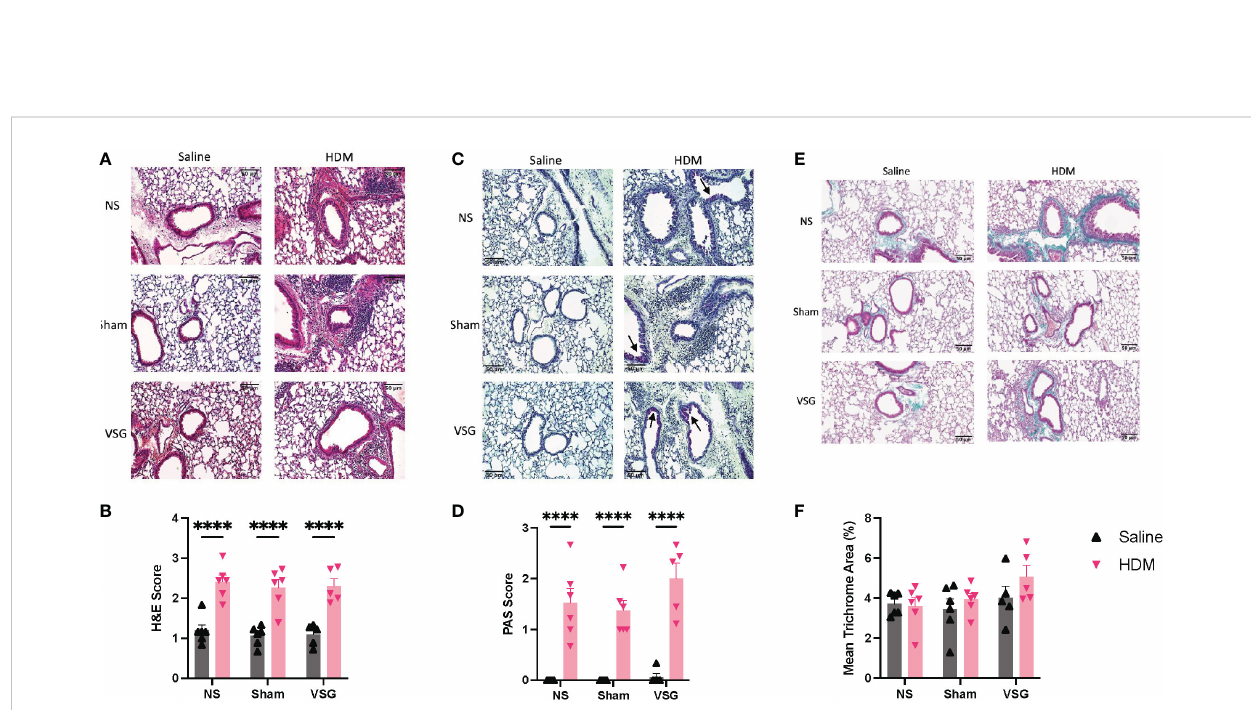
FIGURE 4 Peribronchial in fl ammation, mucus and fi brosis. (A) Representative images of H&E-stained mouse lung sections taken at x20 magni fi cation, scale bar = 50 m m. (B) Mean peribronchial in fl ammation score of H&E-stained lung sections, n=5-6 mice per group, 9-10 airways per mouse. (C) Representative images of PAS-stained mouse lung sections taken at x20 magni fi cation, scale bar = 50 m m. Arrows indicated positively stained cells in airway epithelium. (D) Mean airway mucus score of PAS-stained lung sections, n=5-6 mice per group, 9-10 airways per mouse. (E) Representative images of Masson ’ s trichrome-stained mouse lung sections taken at x20 magni fi cation, scale bar = 50 m m. (F) Mean percentage peribronchial Masson ’ s trichrome staining, n=5-6 mice per group, 9-10 airways per mouse. Grey bars and ▲ = saline-challenged mice; pink bars and ▼ = HDM- challenged mice. (B, D, F) were analyzed using a Two-way ANOVA with a Tukey and Sidak post-hoc test.